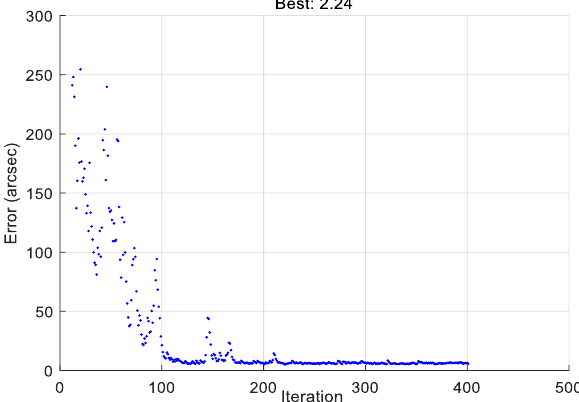
Figure 3. Curve of error variation during optimization.